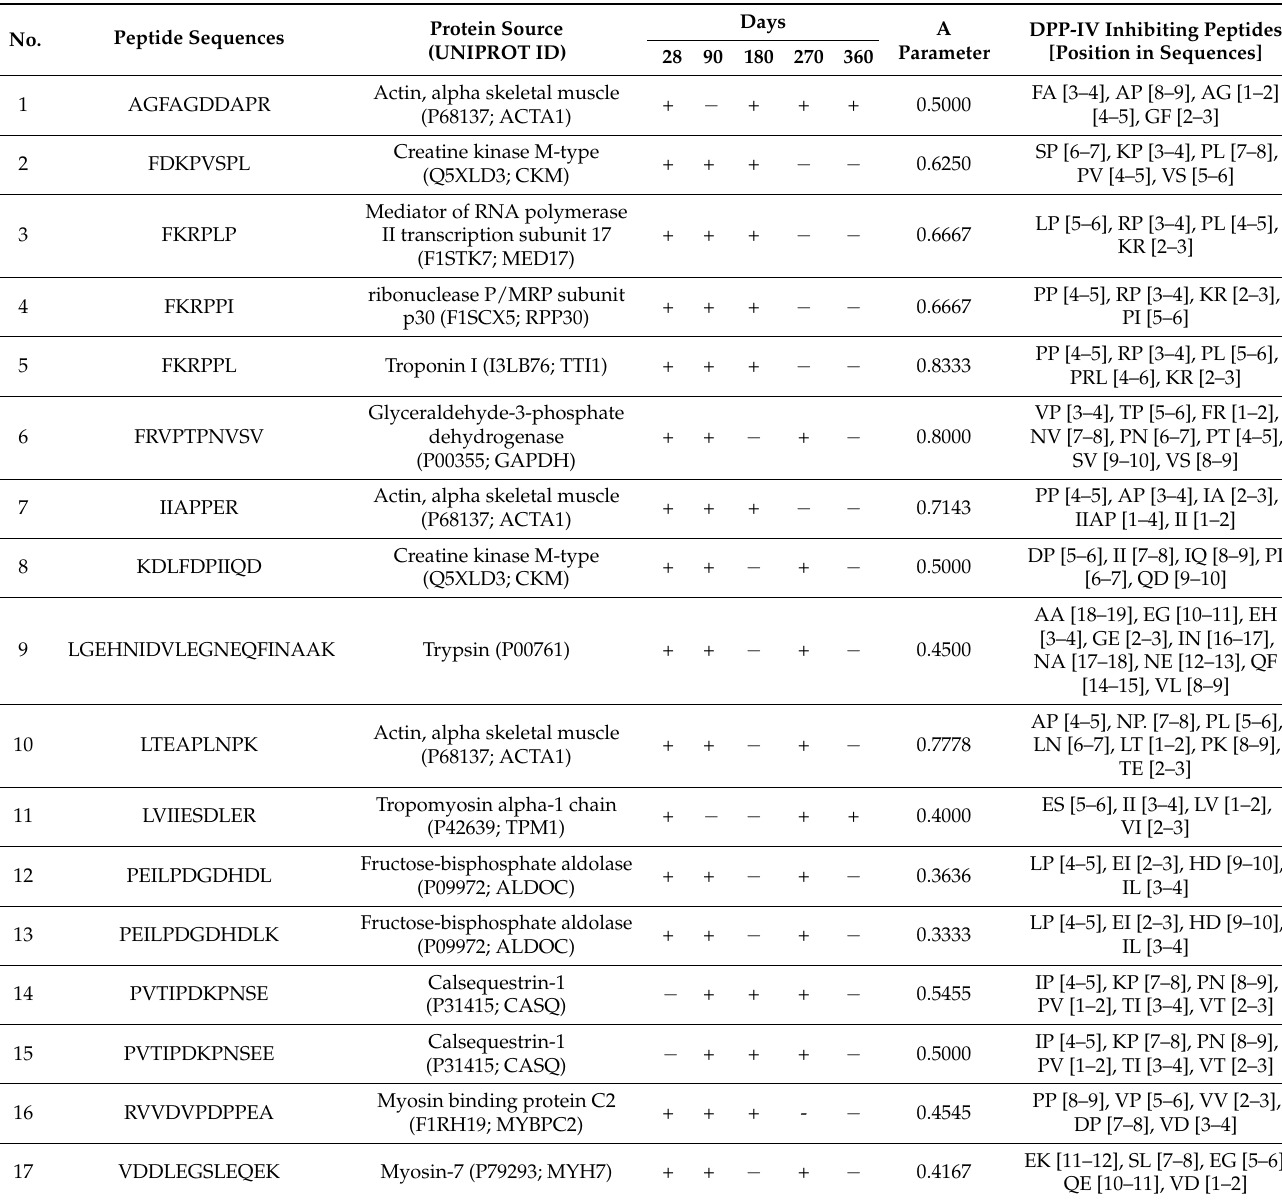
Table 2. Peptide sequences obtained from SSF during 12 months of aging of dry-cured pork loins.